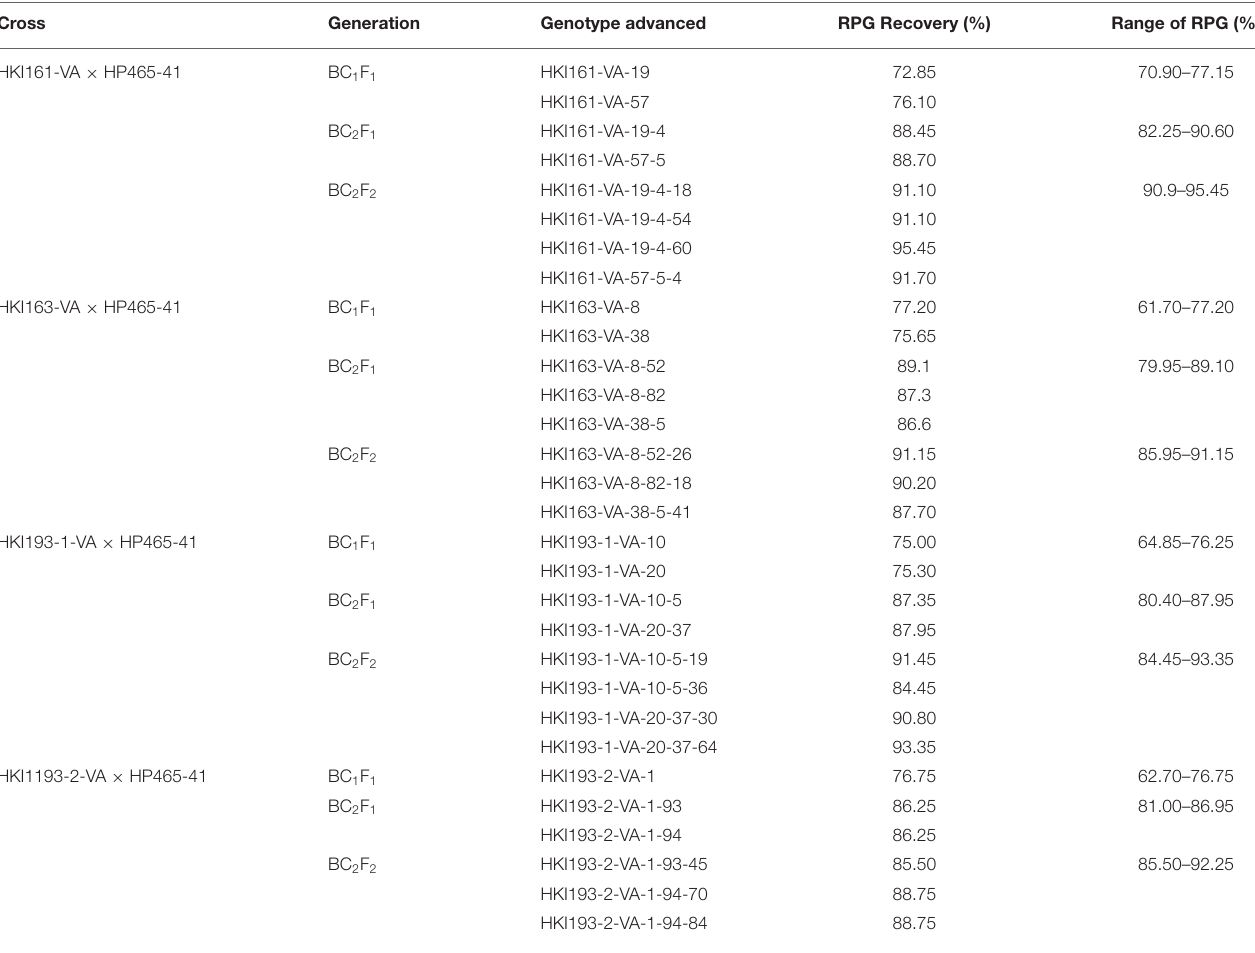
TABLE 2 | Recurrent parent genome (RPG) recovery in the backcross progenies.